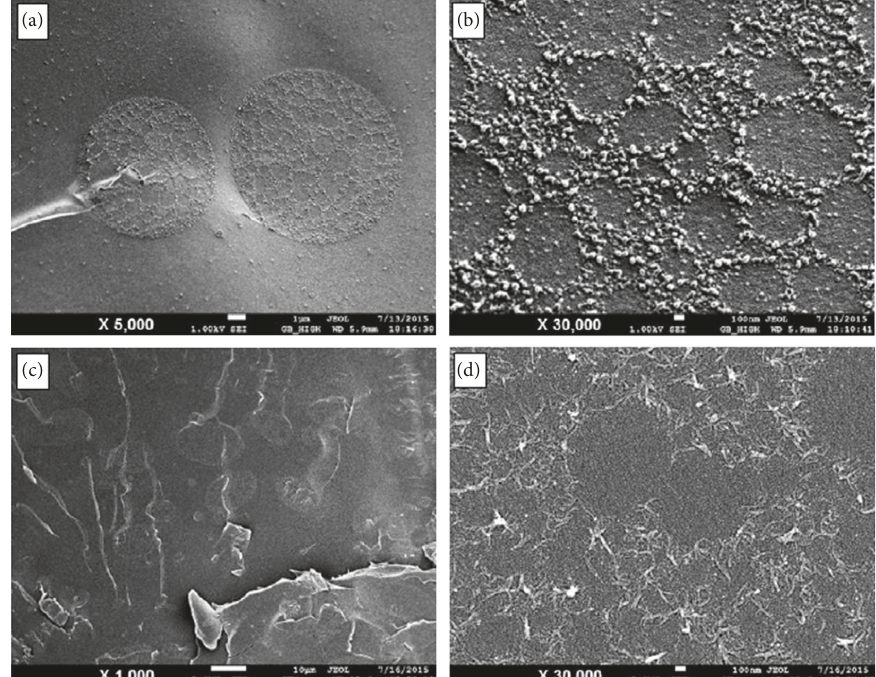
Figure 17: ESEM scan of modified asphalt (3% SBS) (a) 5000x and (b) 30000x. ESEM scan of modified asphalt (5% SBS) (a) 5000x and (b) 30000x. The figure is obtained from Jasso [48] (under the creative commons attribution license/public